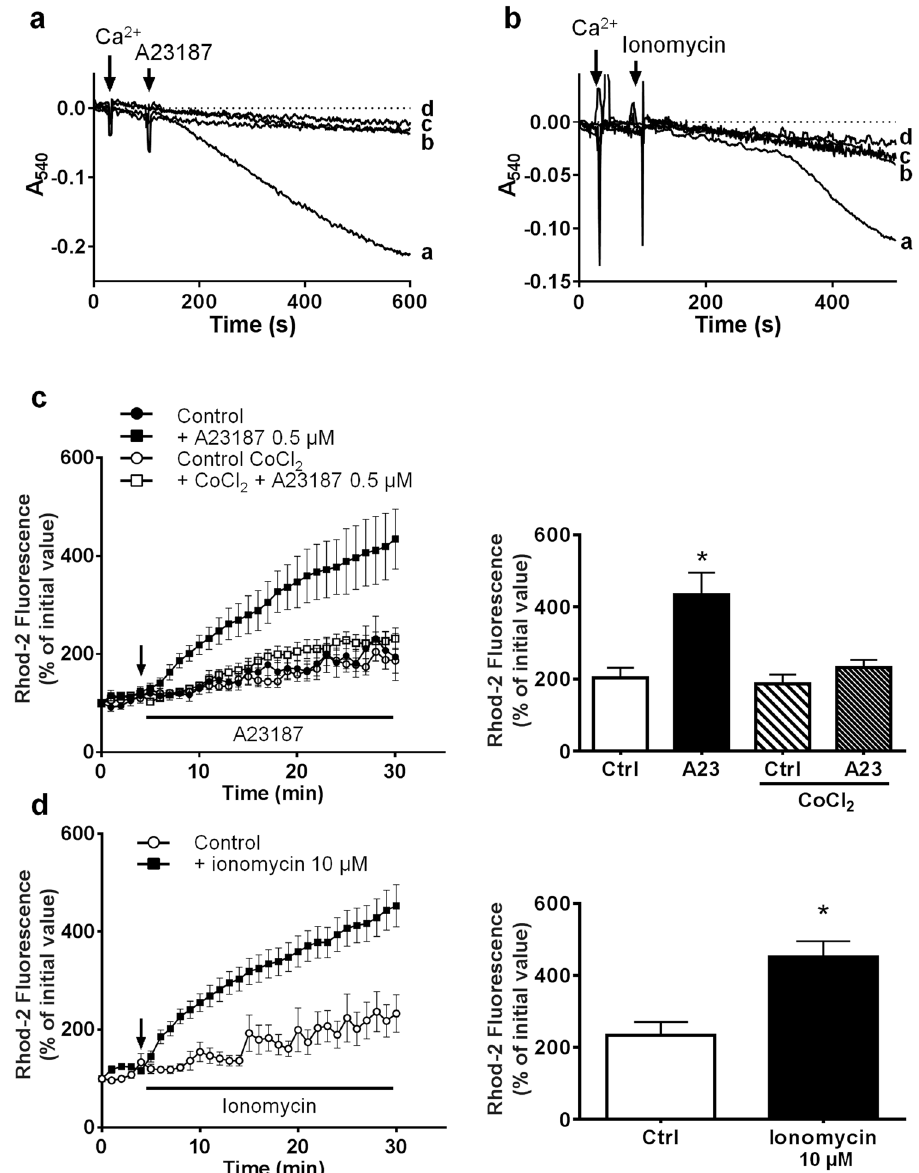
Figure 1. Effect of A23187 and ionomycin on mitochondrial swelling and mitochondrial Ca 2 + in isolated cardiomyocytes. ( a and b ) Swelling was assessed in isolated rat cardiac mitochondria by measuring the change in absorbance of the mitochondrial suspension at 540 nm. Mitochondria were incubated in the presence of rotenone (1 µ M) and antimycin A (1 µ M) in order to inhibit mitochondrial respiration. Then 200 µ M Ca 2 + and 1 µ M A23187 or 10 µ M ionomycin were added. ( a ) line a: Ca 2 + + A23187; line b: Ca 2 + + A23187 + CsA 2 µ M; line c: Ca 2 + alone; line d: A23187 alone. ( b ) line a: Ca 2 + + ionomycin; line b: Ca 2 + + ionomycin + CsA 2 µ M; line c: Ca 2 + alone; line d: ionomycin alone. ( c , d ) Isolated adult cardiomyocytes were loaded with 5 µ M rhod-2 for 40 min at 37 °C and then incubated in a Tyrode’s buffer. After 5 min incubation (arrow) A23187 ( c ) or ionomycin ( d ) were added to the medium. Fluorescence values were obtained by averaging pixel intensities after background substraction and were normalised as a percentage of the initial value. Each trace represents the mean ± SEM of 3–5 experiments. * p < 0.05 versus control (Ctrl). The ordinates of the bar graphs are the values of rhod-2 fluorescence observed at 30 min in the corresponding